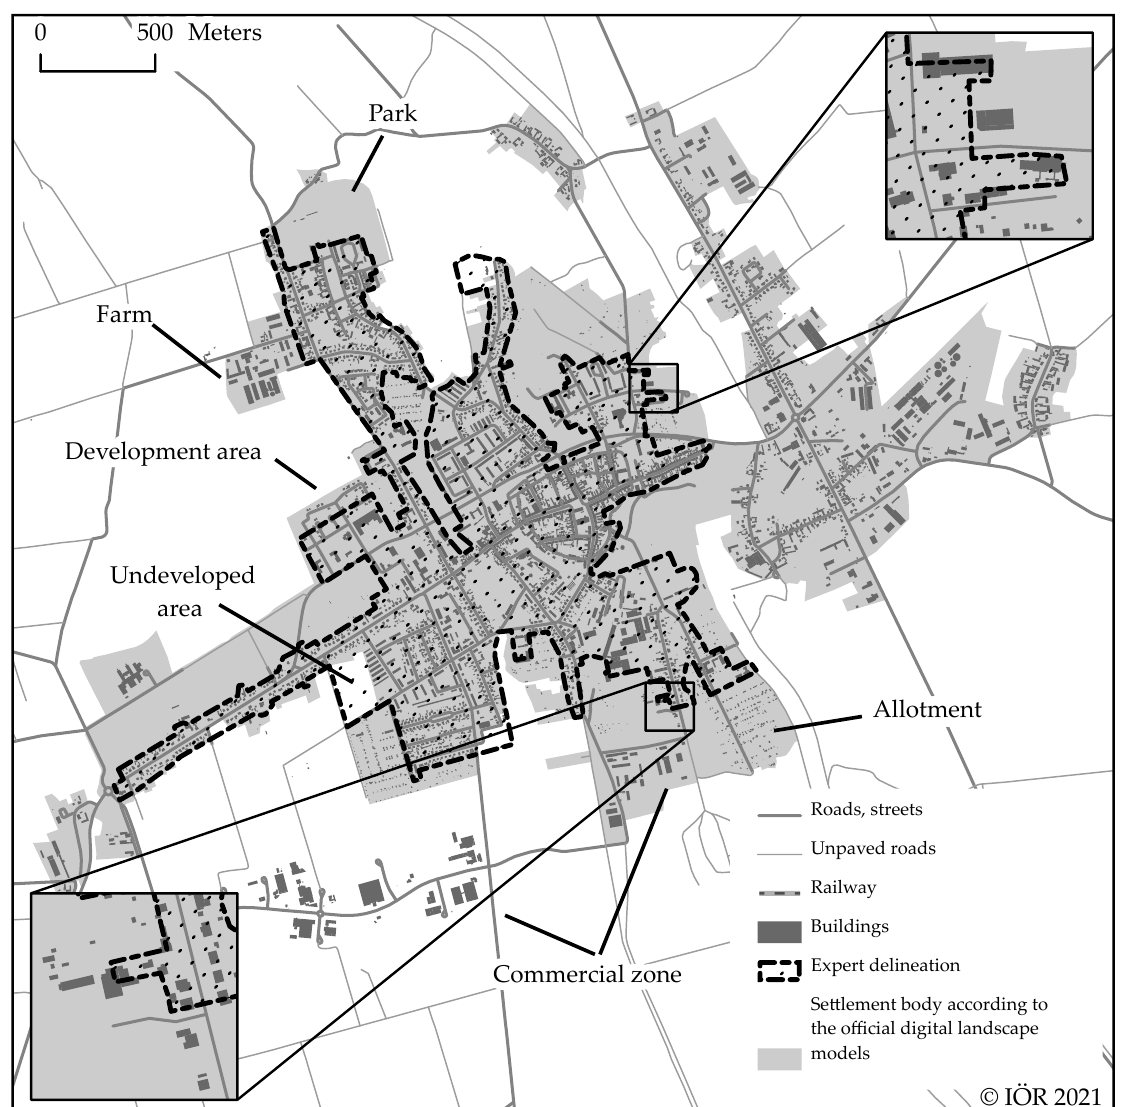
Figure 1. Using the municipality of Herzberg (Elster) in Germany as an example, the illustration shows the differences between the delineation of the settlement body (ATKIS ® -Ortslage) according to the official digital landscape models (DLM) and an expert delineation (ED) of an inner zone by statute. ( source : own illustration based on data from official building polygons, ATKIS ® -Ortslage Base-DLM © Geobasis-DE/BKG (2017) and Planning Information System of the Joint State Planning Department